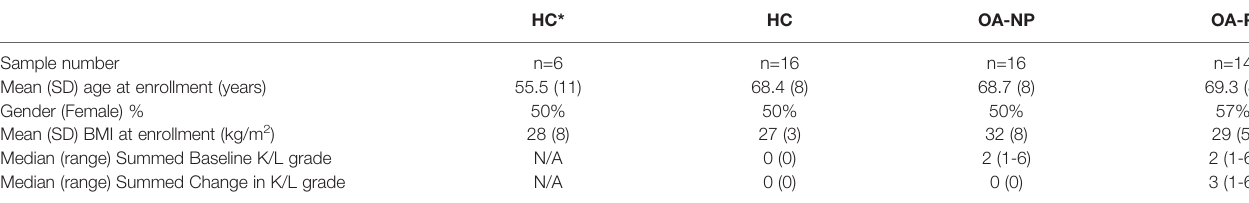
HC, healthy control; *obtained from Zenbio; OA-P, radiographic knee osteoarthritis progressor; OA-NP, radiographic knee osteoarthritis non-progressor; SD: standard deviation; BMI, body mass index; K/L grade, Kellgren and Lawrence grade; N/A, not